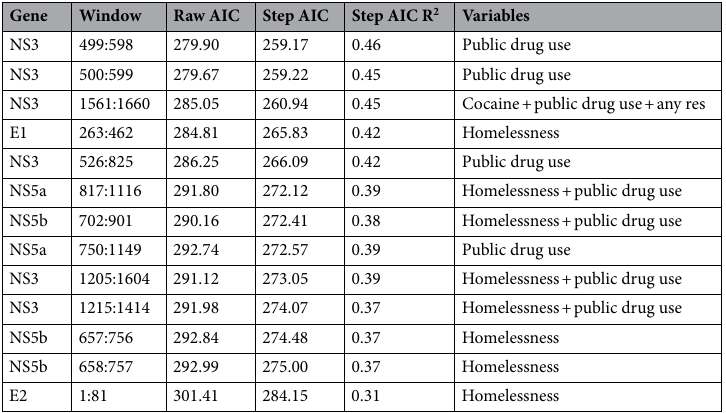
Table 4. Linear models with and without behavioural variables. Models were built for each full gene as well as for each specified region. AICs are shown for linear models without clinical data generated from the data set (Raw AIC) as well as when all variables were included (step AIC) along with the R 2 values for the step AIC models (stepAIC R 2 ). Any Res. are samples with any resistant positions detected.